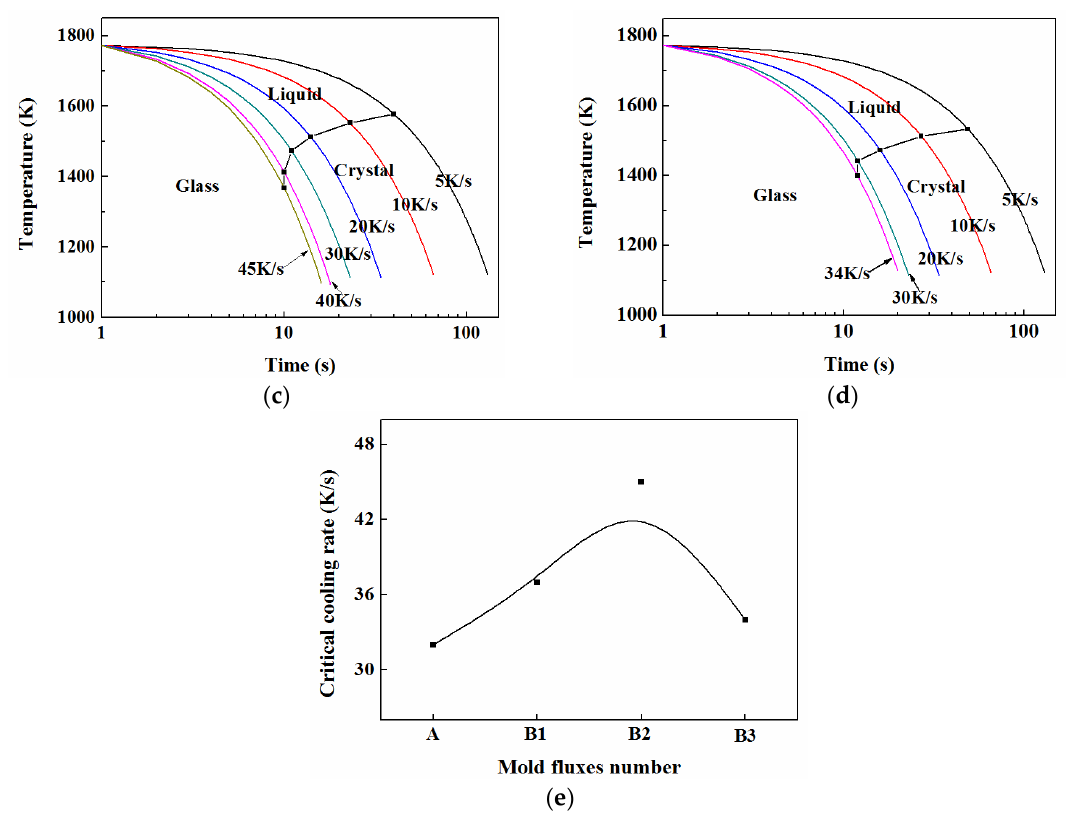
Figure 9. CCT curves of mold fluxes. ( a ) A, ( b ) B1, ( c ) B2, ( d ) B3, and ( e ) critical cooling rate of mold fluxes.